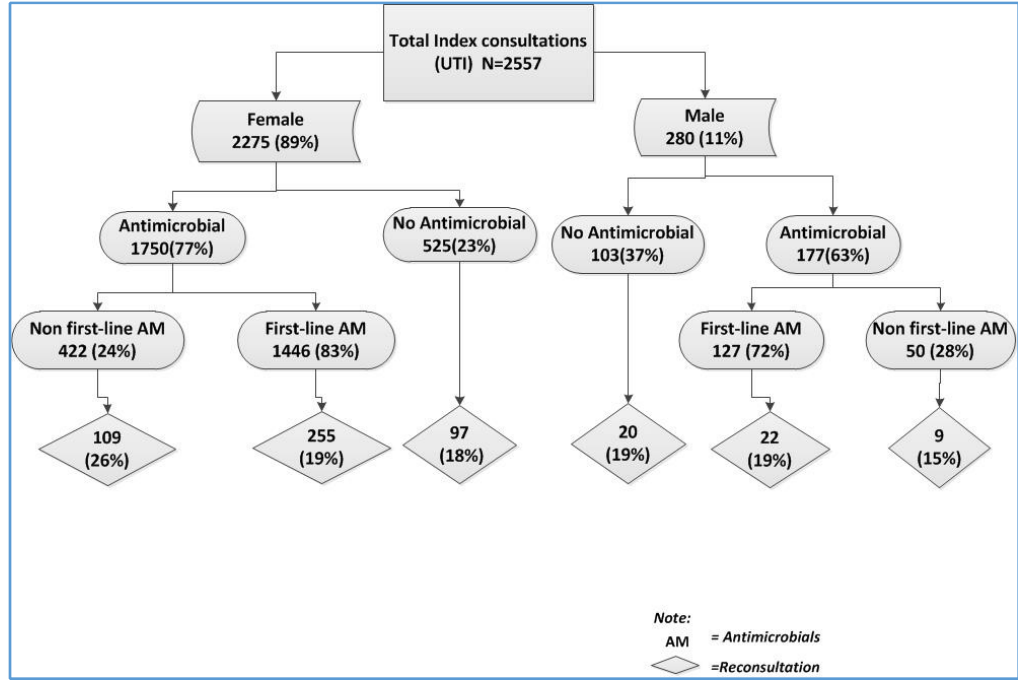
Figure 3. Flow chart of the reconsultations according to gender and first ‐ line treatment of antimicrobials.